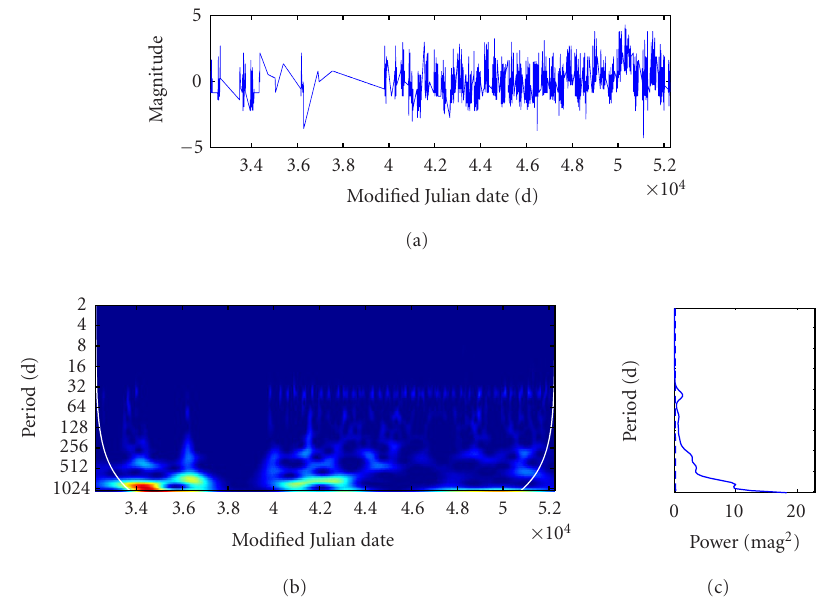
Figure 8: (a) RV Tauri light curve. (b) Wavelet power spectrum. The continuous white line indicates the cone of influence. (c) Global wavelet spectrum of the simulated signal with a Morlet wavelet. The 95% confidence level that could be obtained for a white noise is shown by the dashed